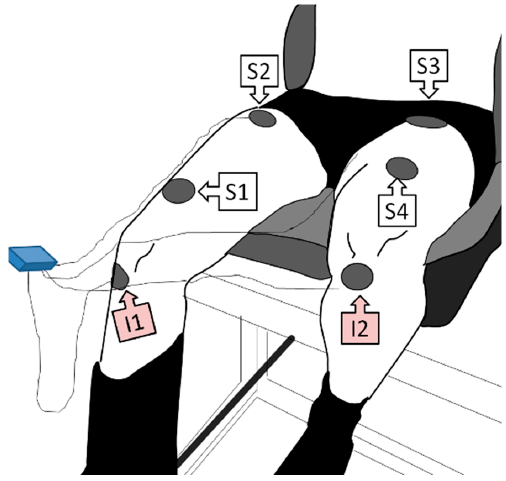
Figure 4. Example of subject instrumentation for BIS in the right thigh (S1,S2), in the pelvis (S2,S3) and in the left thigh (S3,S4).